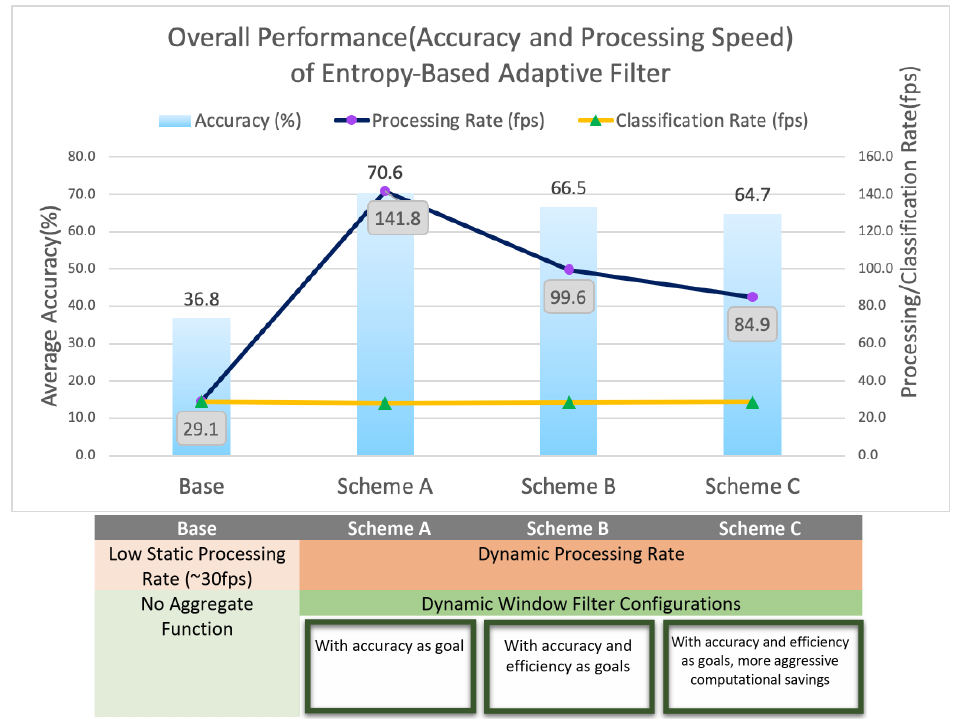
Figure 9. Overall performance of entropy-based adaptive